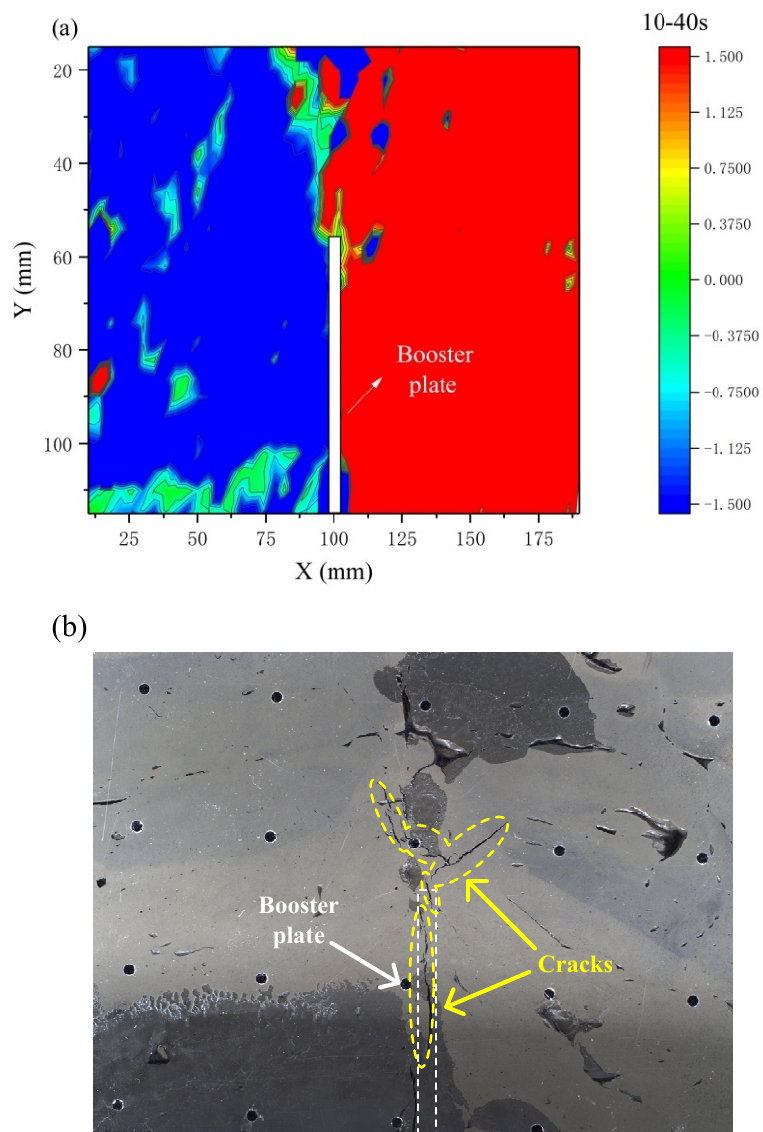
Figure 10. PIV results for a time period of 10~40 s of air boosting: ( a ) coloured contour on horizontal displacement; ( b ) slurry picture taken on time instant t * = 40 s.